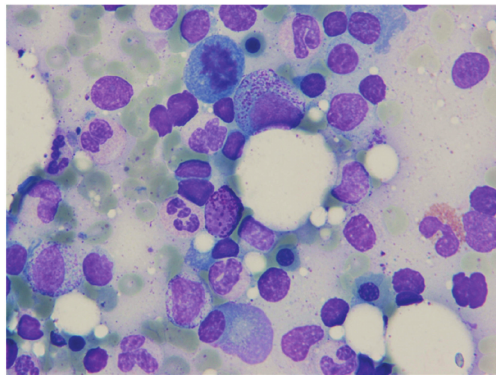
Figure 4: Myeloid and erythroid cells in mid-power microscopic view. Wright stain × 400.